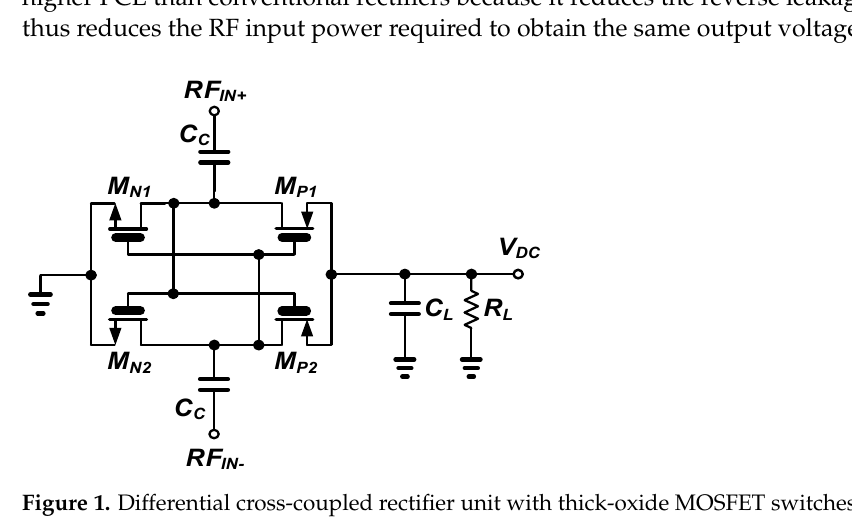
Figure 1. Differential cross-coupled rectifier unit with thick-oxide MOSFET switches.